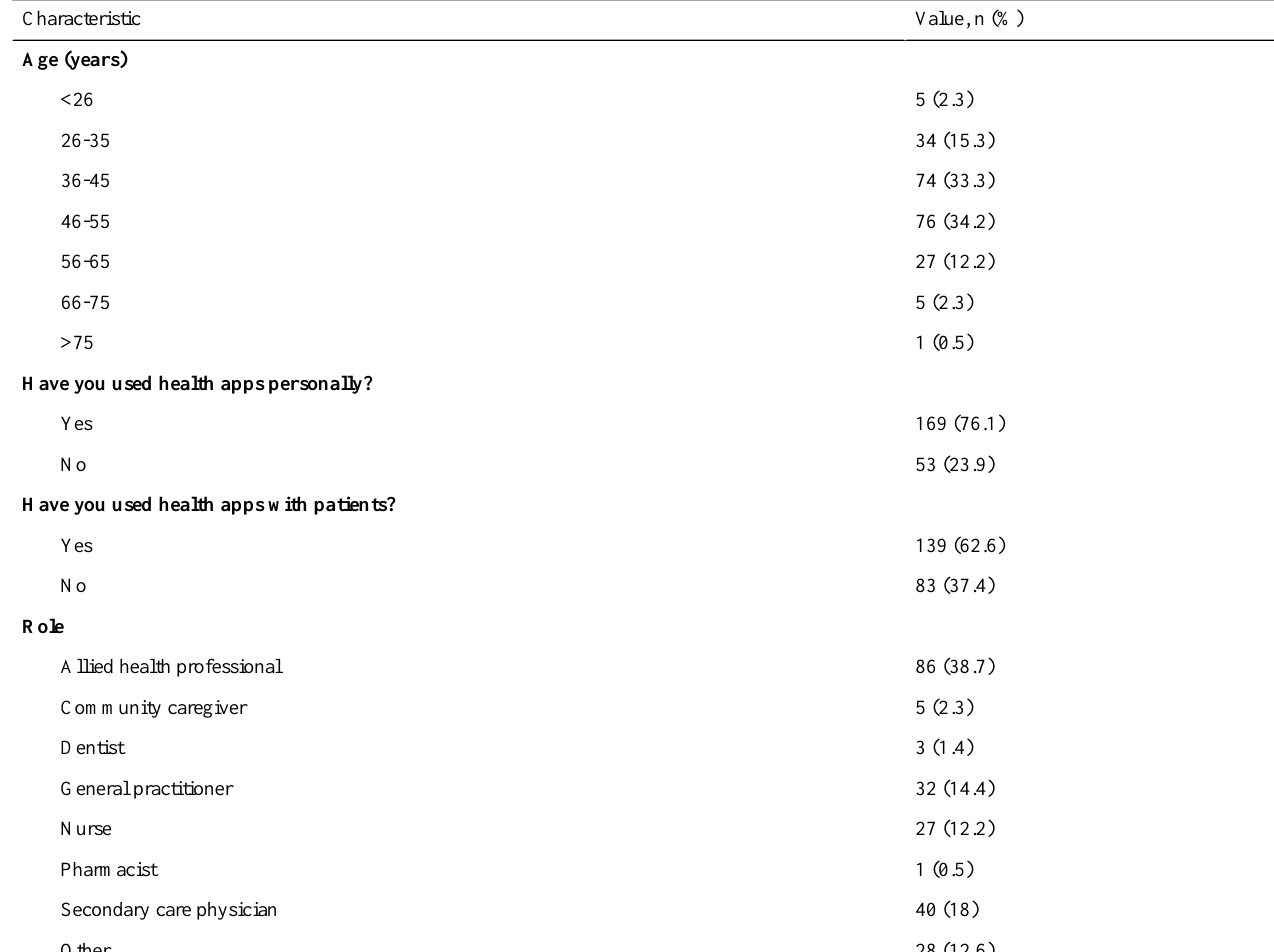
Table 2. Characteristics of health care professionals completing the discrete choice experiment